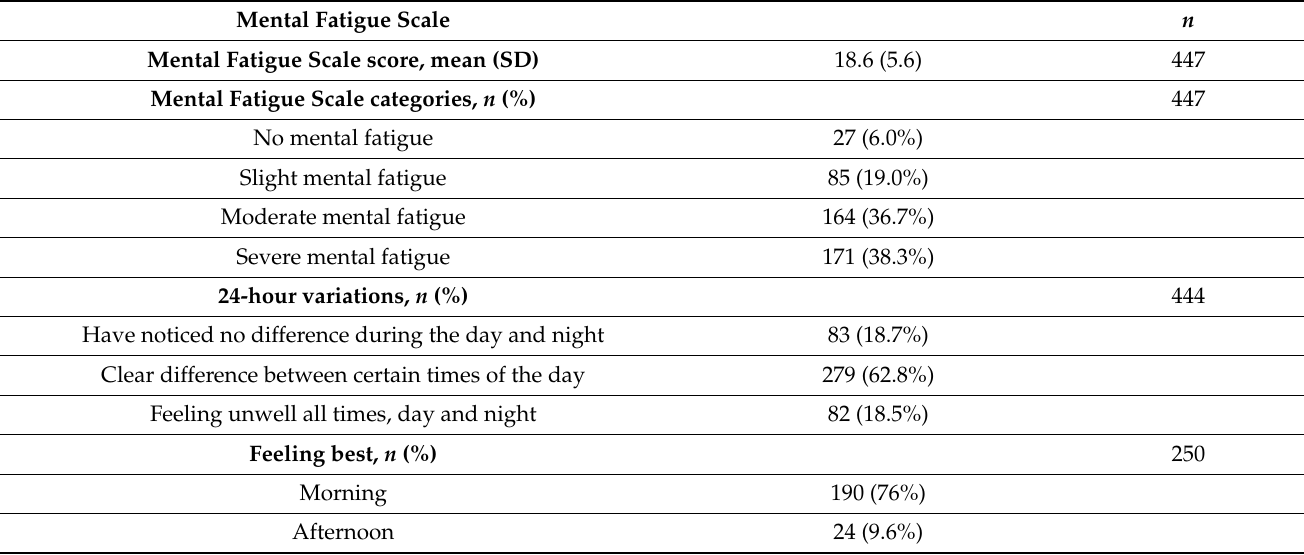
Table 2. Mental Fatigue Scale. Mean score, degree of mental fatigue and 24 h symptom variations. The scores reflect the patients’ current conditions (the past month) with long COVID compared to before infection with SARS-CoV-2